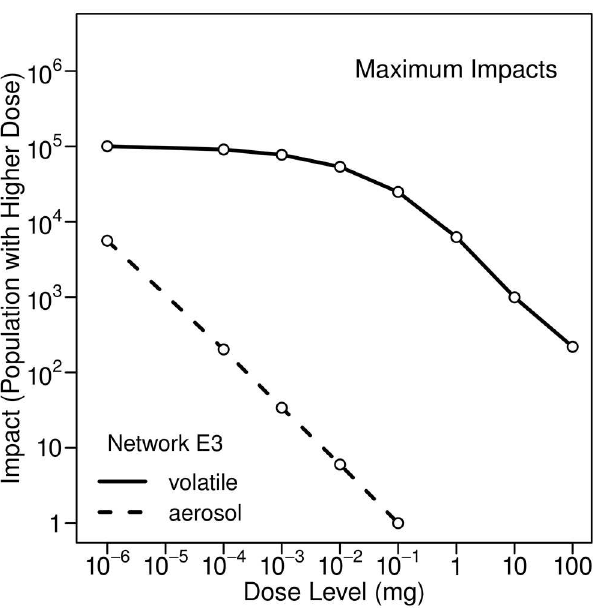
Fig 8. Maximum impacts from inhalation of volatile and nonvolatile contaminants during showering. Results are for Network E3 from two separatesimulations, both using 10-kg injections at 0:00 hours. Nonvolatilecontaminants are in aerosols in the shower